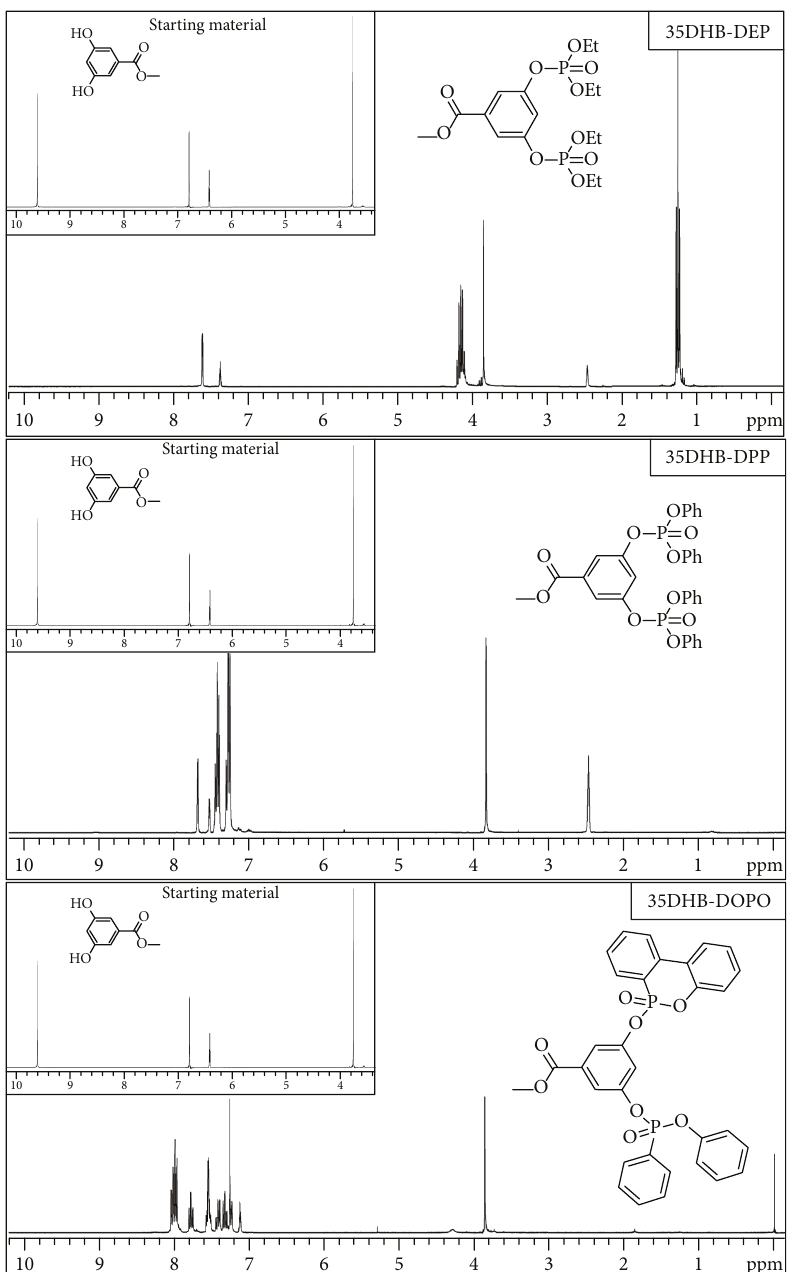
Figure 4: 1 H NMR spectra of phosphorus esters of methyl 3,5-dihydroxybenzoate. All the esters display good thermal stability (Table 5). Two esters, the diphenyl phosphate and the DOPO phosphonate, display decomposition onset temperatures above 300 °